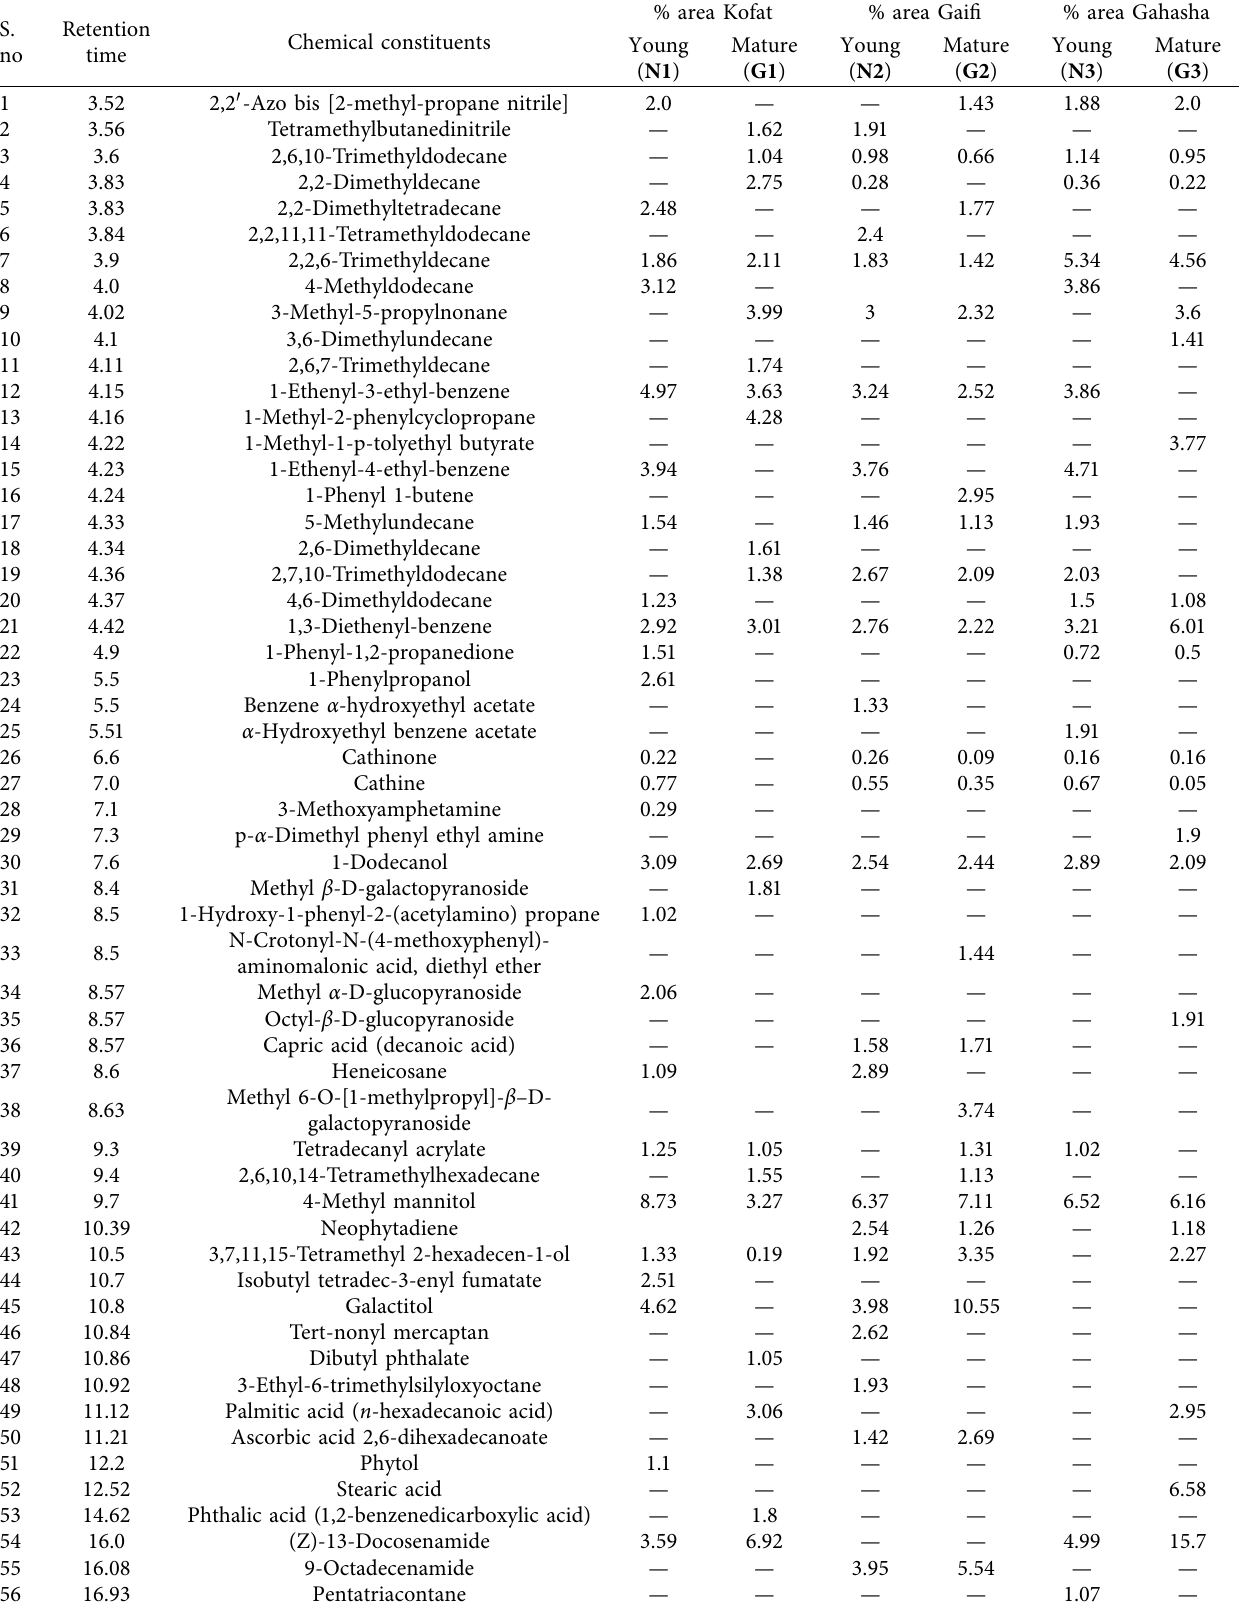
Table 1: Chemical composition of alcoholic extract of young and mature leaves of Kofat, Gaifi, and Gahasha species.